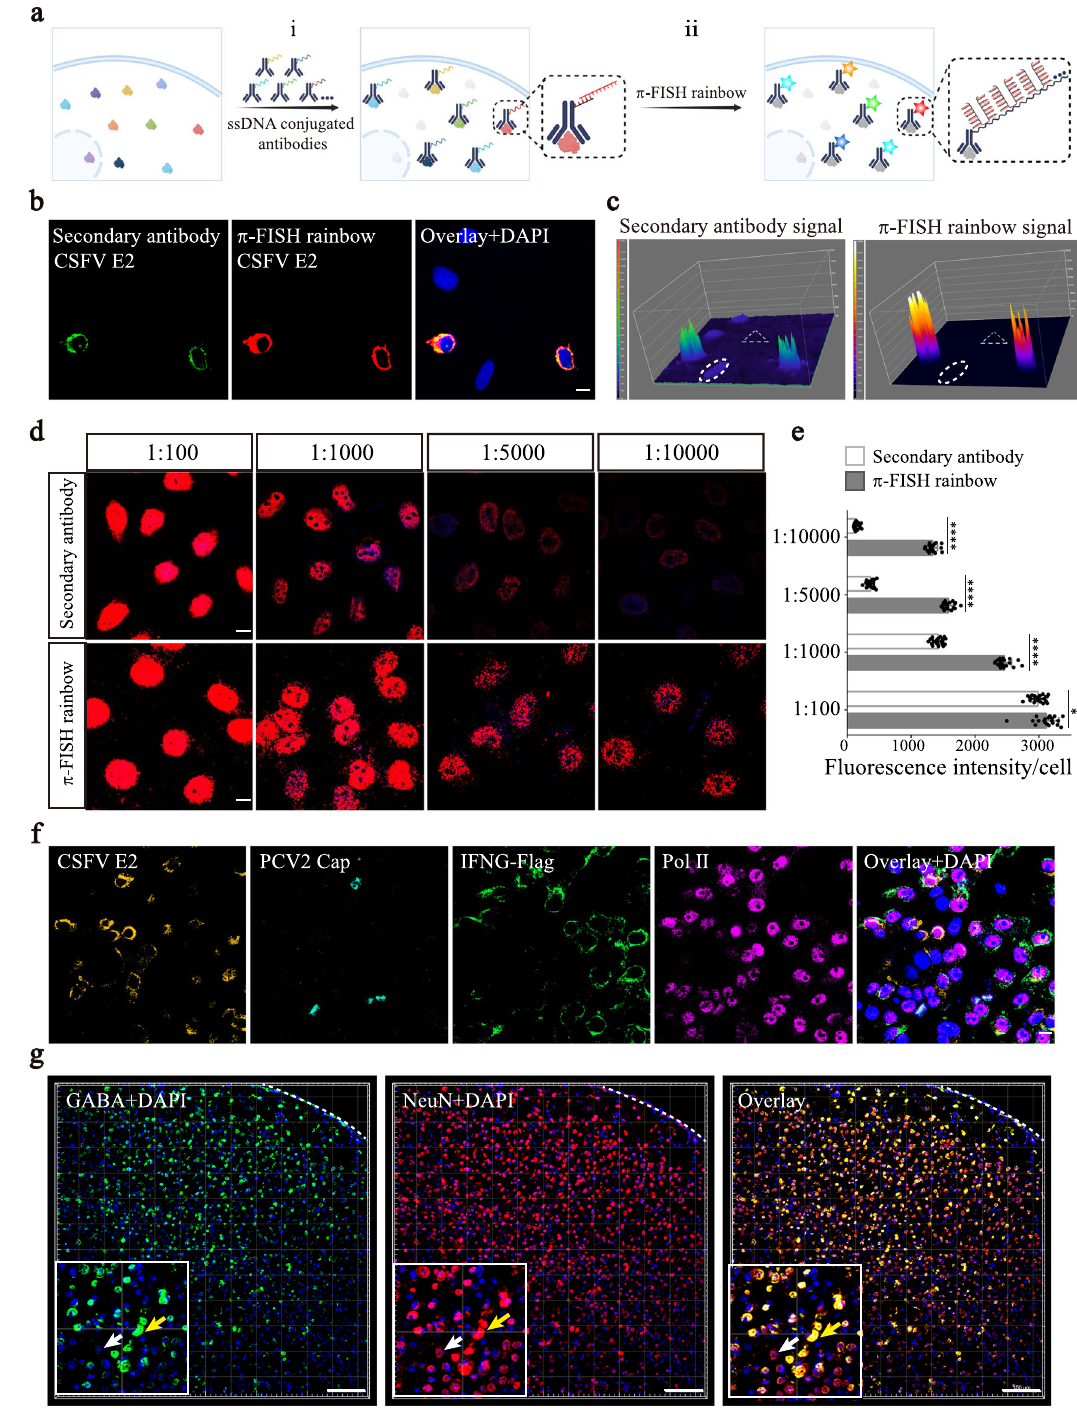
Fig. 3 | In situ detection ofproteins and neurotransmitters by π -FISHrainbow. a Schematic for in situ detection of multiple proteins and neurotransmitters by π - FISH rainbow. (i) Antibodies were conjugated to barcoded ssDNA and then incu- batedwith target proteins and neurotransmitters. (ii) Hybridizationof probeswith barcoded ssDNA and signal ampli fi cation using π -FISH rainbow. b Detection of CSFV E2 protein in HeLa cells, transfected with the rAAV-E2 plasmid, by π -FISH rainbow and conventional immunostaining, respectively. Scale bar, 10 μ m. c Intensitysurface plotanalysisof ( b ).Cellslacking E2 proteinand background are indicated by oval region and triangular area, respectively. d Detection of pol II protein by conventional immunostaining (top) and π -FISH rainbow (bottom) with different dilutions of primary antibody (1:100, 1:1000, 1:5000, and 1:10,000),